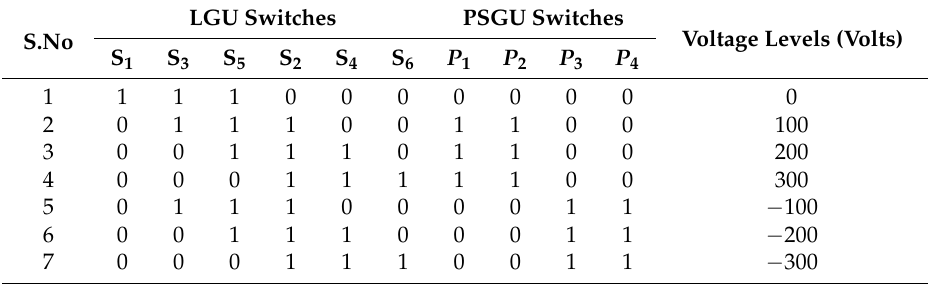
Table 3. Switching sequence to generate seven-level output for a DCLCHB